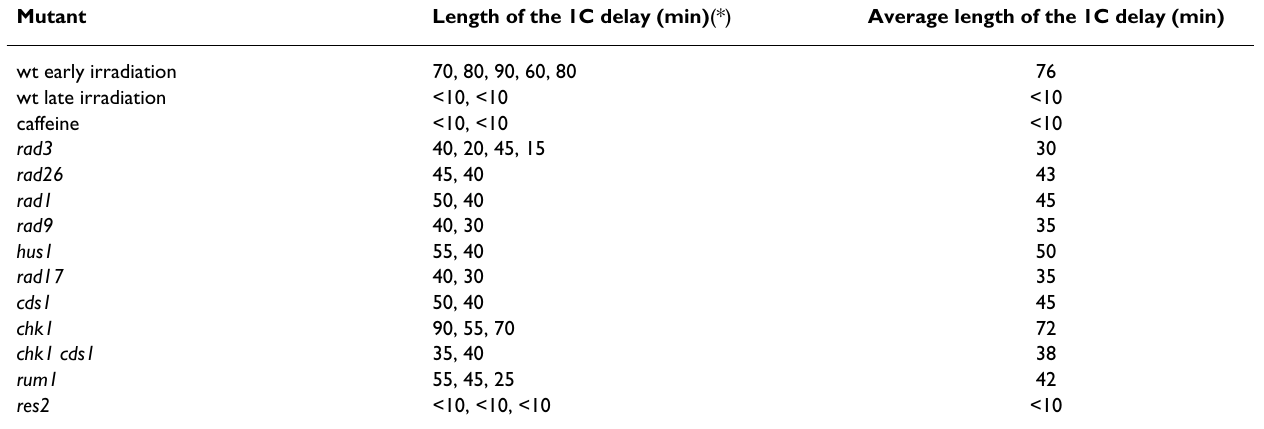
(*) The length of the delay was measured at the point where 50% of the cells had a 1C DNA content on the quantitations. The second column shows the results of individual experiments, the third column shows the average lengths of the delay. Irradiations were carried out 3.5 hours after inoculation in medium, except for the entry "wt late irradiation", which was performed 4.5 hours after